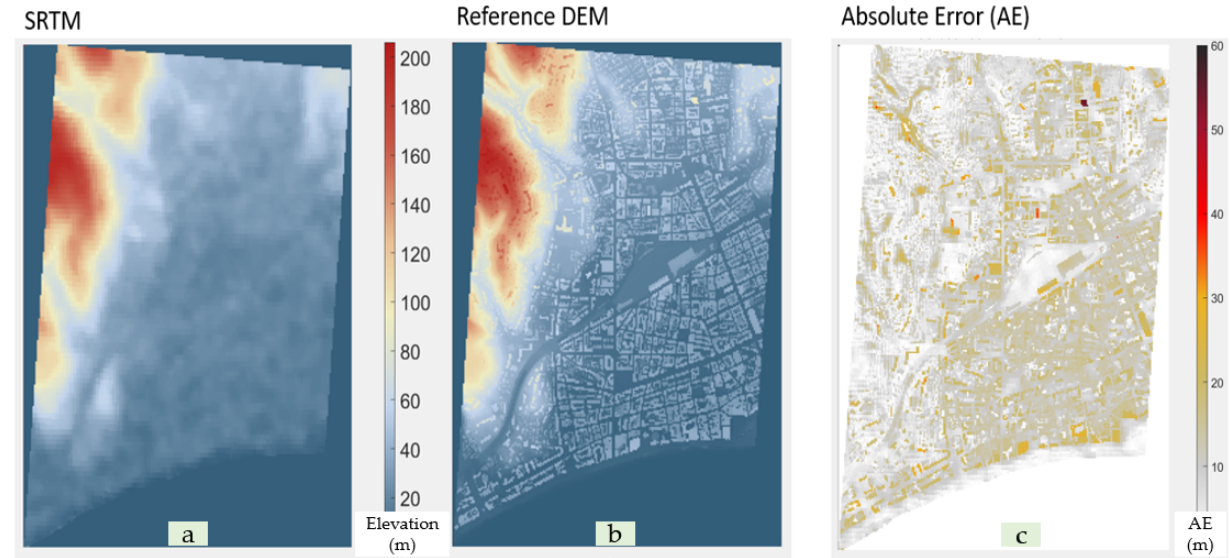
Figure 6. Elevation map at validation site of: ( a ) SRTM-DEM, ( b ) reference DEM and ( c ) absolute error between reference DEM and SRTM DEM.